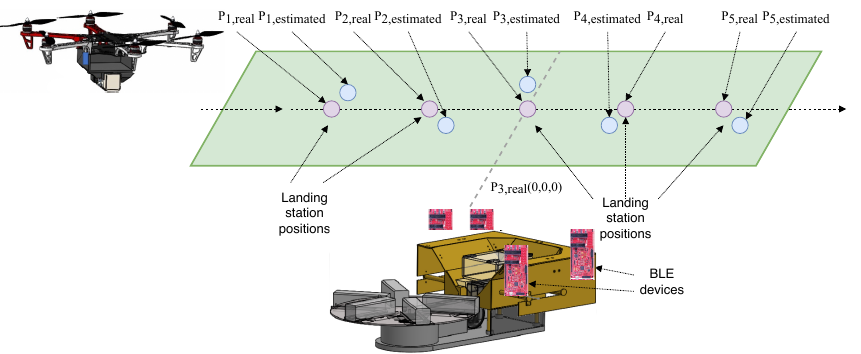
Figure 11. MLE-based target position estimation test.